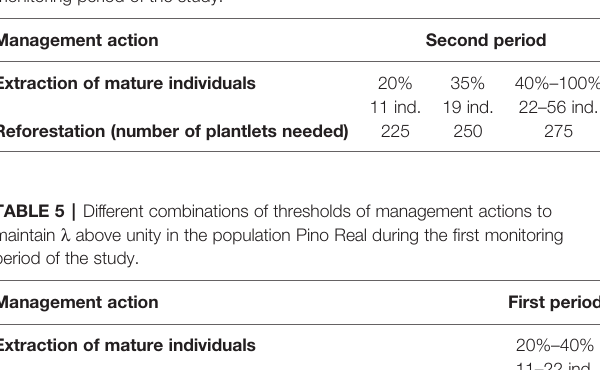
TABLE 4 | Different combinations of thresholds of management actions to maintain l above unity in the population Piedra de Indio during the second monitoring period of the study.